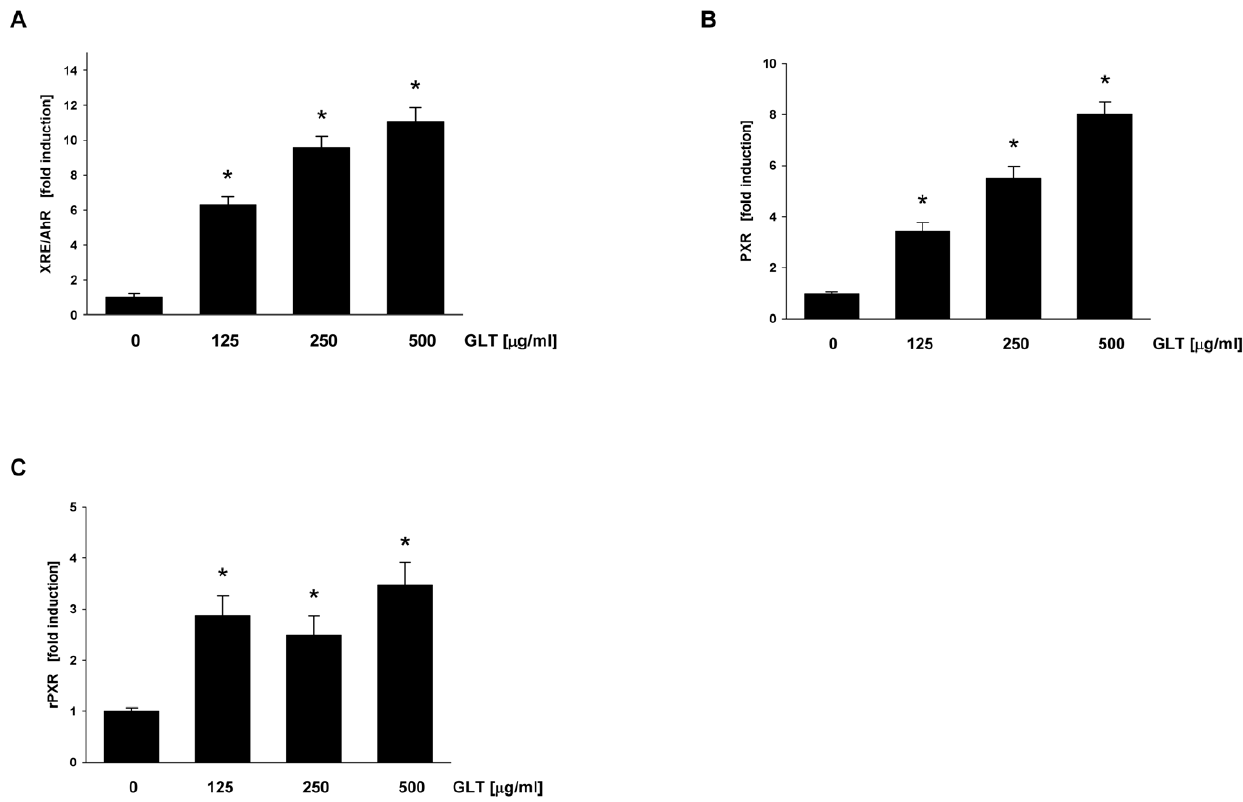
Figure 6. GLT activates XRE/AhR, PXR and rPXR. invitro . Induction of (A) XRE/AhR, (B) PXR and (C) rPXR was evaluated as described in Materials and Methods . Results are means 6 SD (n=4), *p , 0.05 by ANOVA.